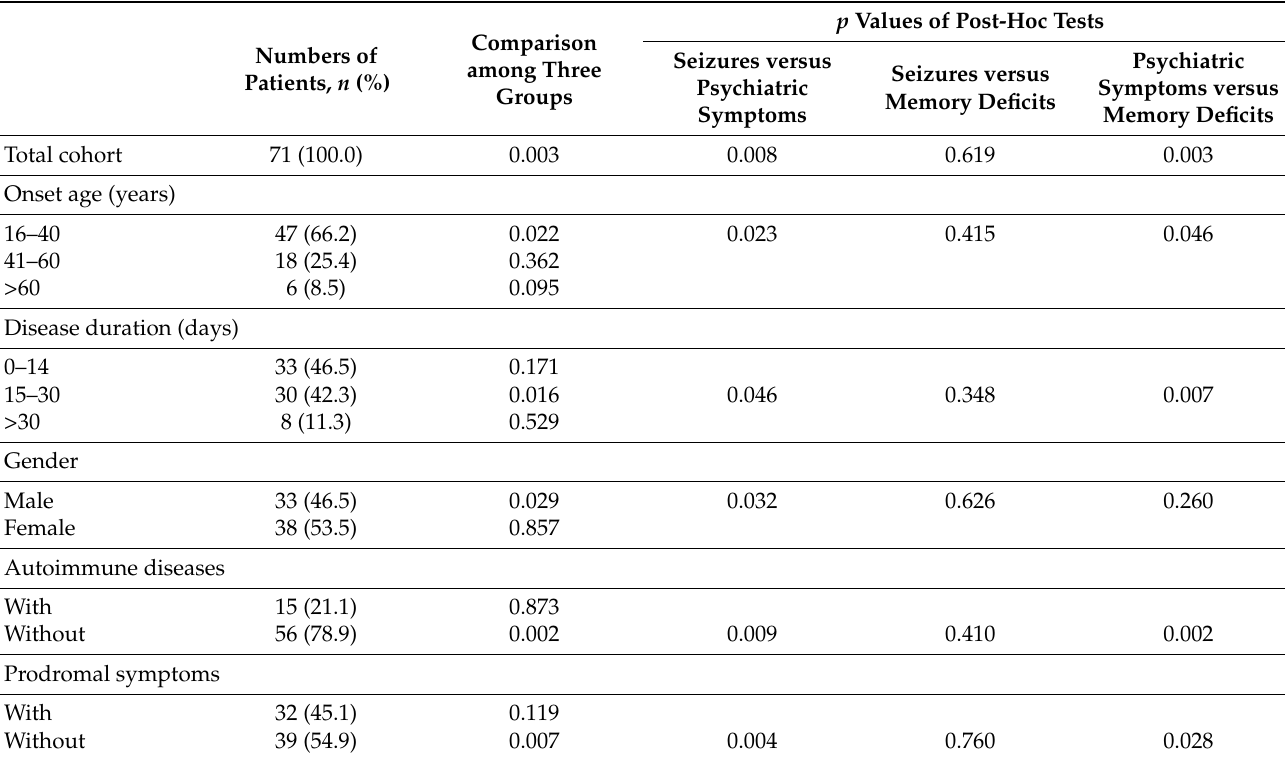
Comparison of cerebrospinal fluid antibody titers among groups with different onset